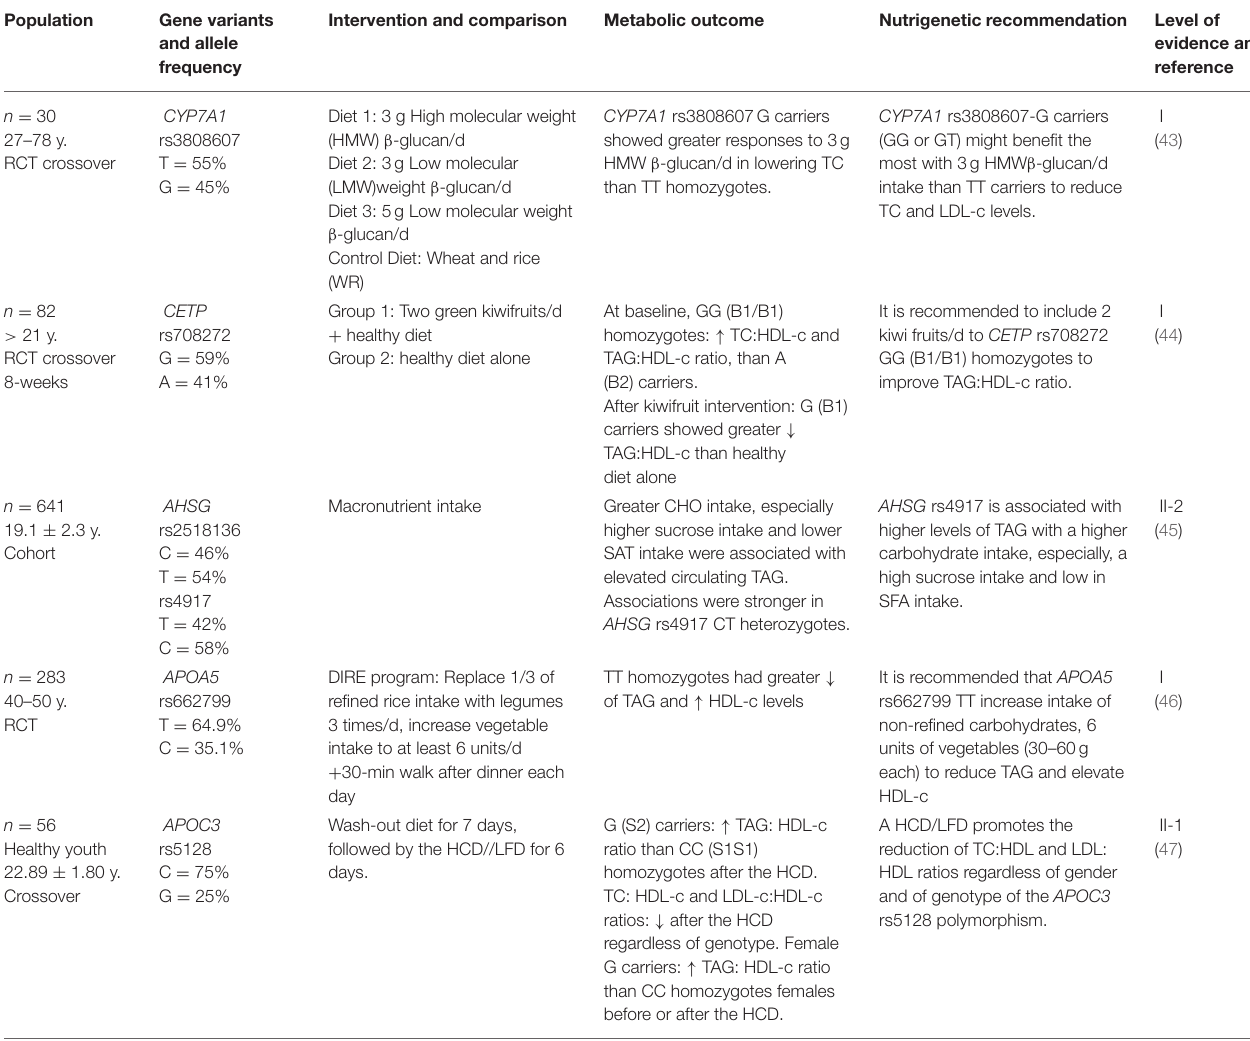
TABLE 2 | Gene diet interaction with carbohydrates and fiber. Population Metabolic outcome Nutrigenetic recommendation Level of